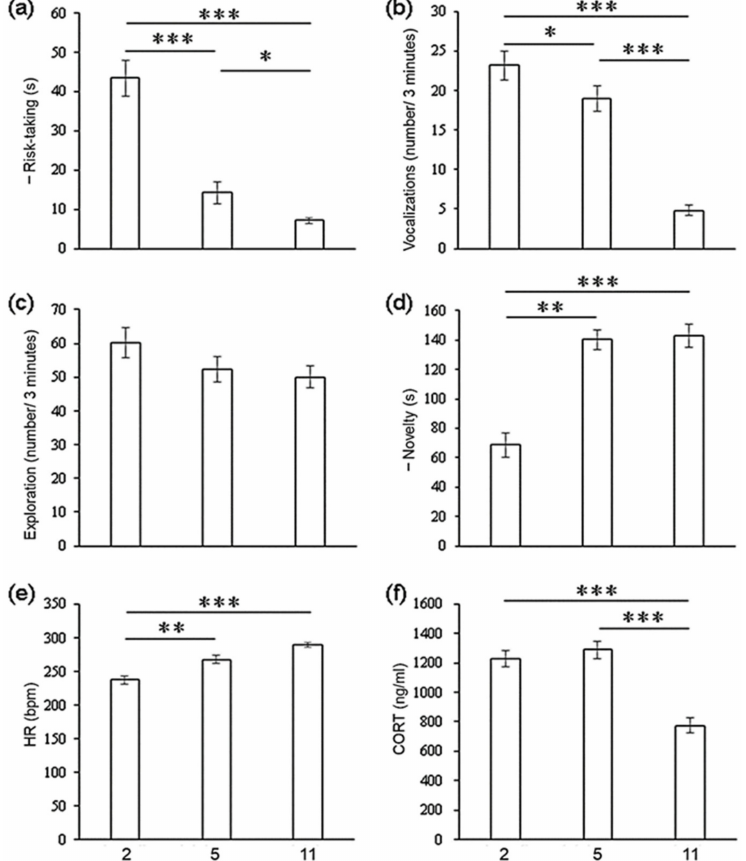
Figure 2. Mean differences in behavioral and physiological traits at three age stages (2, 5, and 11 months old). ( a ) Risk-taking, ( b ) vocalizations, ( c ) exploration, ( d ) novelty, ( e ) HR (heart rate), and ( f ) CORT (fecal cortisol concentration). Mean differences in CORT were analyzed by one-way ANOVA and the LSD method (LSD0.05); differences in the other variables were tested with a non- parametric Wilcoxon signed-rank test. Error bars indicate standard error. * p < 0.05, ** p < 0.01, *** p < 0.001. Note: “—” indicates higher risk-taking and novelty and shorter